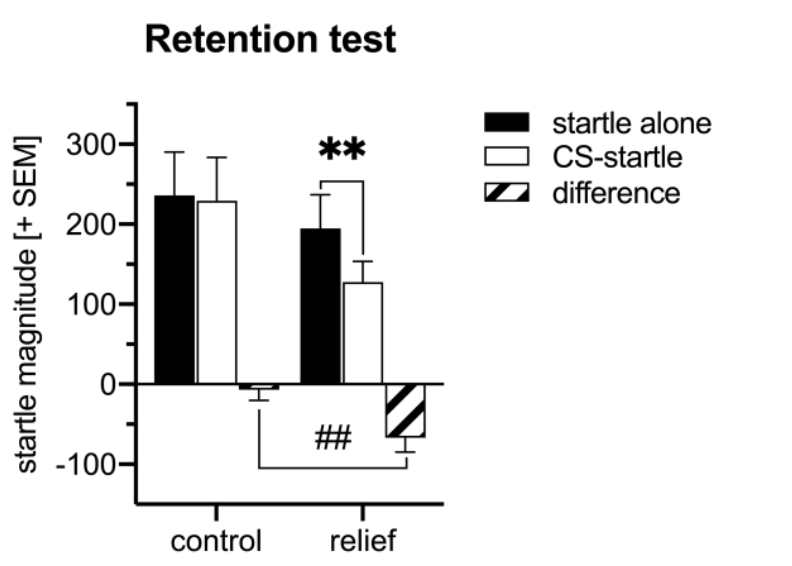
Figure 2. The retention test on conditioned relief showed significant attenuation of the startle mag- nitude in relief-conditioned rats but not in control-conditioned animals ( n = 12/group). ** p < 0.01, ## p < 0.01.